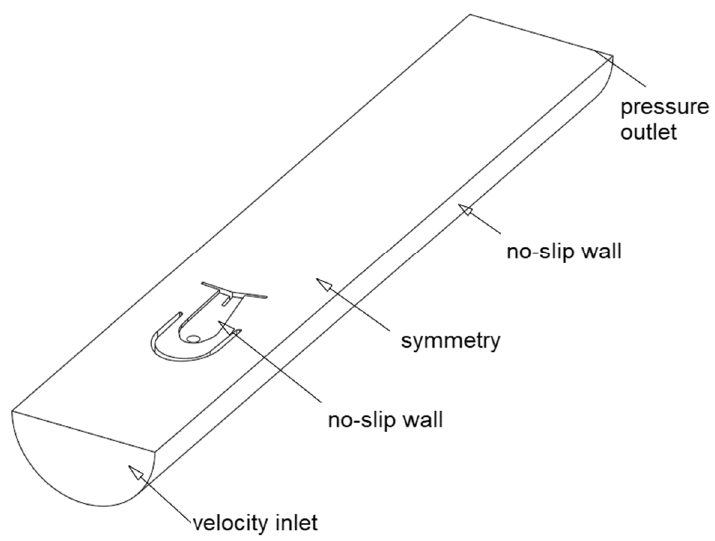
Figure 8. Boundary conditions for the three-dimensional case.